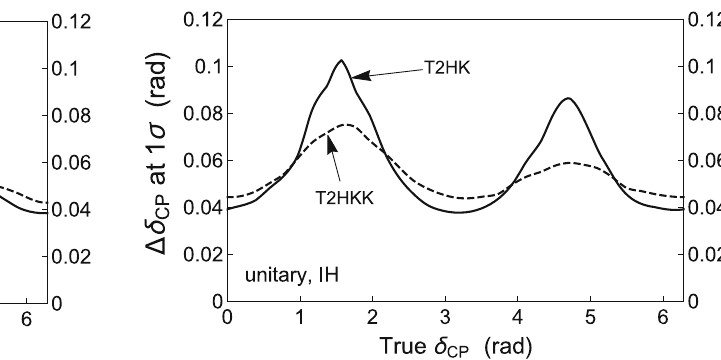
mass hierarchy is normal and inverted, respectively. In each plot, the solid line indicates the sensitivity in the T2HK, and the dashed line the sensitivity in the